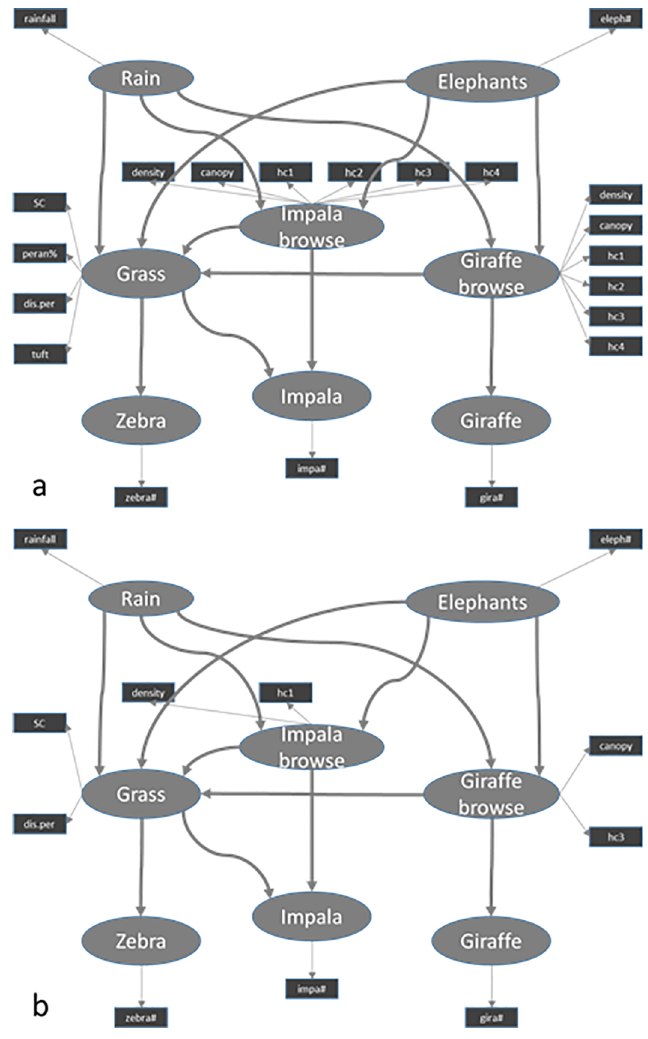
Fig 1. Initial total path model and used total path model. (a) The initial path model with all manifest variables which could describe the latent variables. (b) The final path model after removing manifest variables. Goodness of fit = 0.49. Circles show the latent variables and squares show the manifest variables. Arrows between latent variables indicate interactions and arrows toward manifest variables show which variables describe the latent variable.